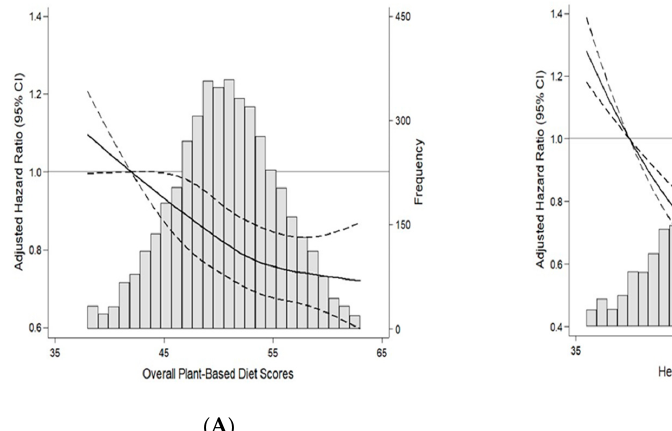
Figure 1. Multivariable adjusted hazard ratios and 95% confidence intervals for incident dyslipidemia according to the continuous plant-based diet index using restricted cubic splines. The histogram in gray shows the distribution of plant-based diet scores. The solid lines represent the multivariable adjusted hazard ratios for incident dyslipidemia, modeled using restricted cubic splines with 4 knots (5th, 35th, 65th, 95th percentiles). The reference was point was set at the 5th percentile of each score. The dashed lines represent 95% confidence intervals. ( A ) Overall plant-based diet score, ( B ) healthful plant-based diet score, ( C ) unhealthful plant-based diet score. Hazard ratios were adjusted for age (year, continuous), sex (men/women), residence area (rural/urban), education ( ≤ 6, 7–12, >12 years), physical activity (MET/day, continuous), pack-years of cigarettes (continuous), alcohol intake (g/day, continuous), body mass index (kg/m 2 , continuous), and total energy intake (kcal/day, continuous).